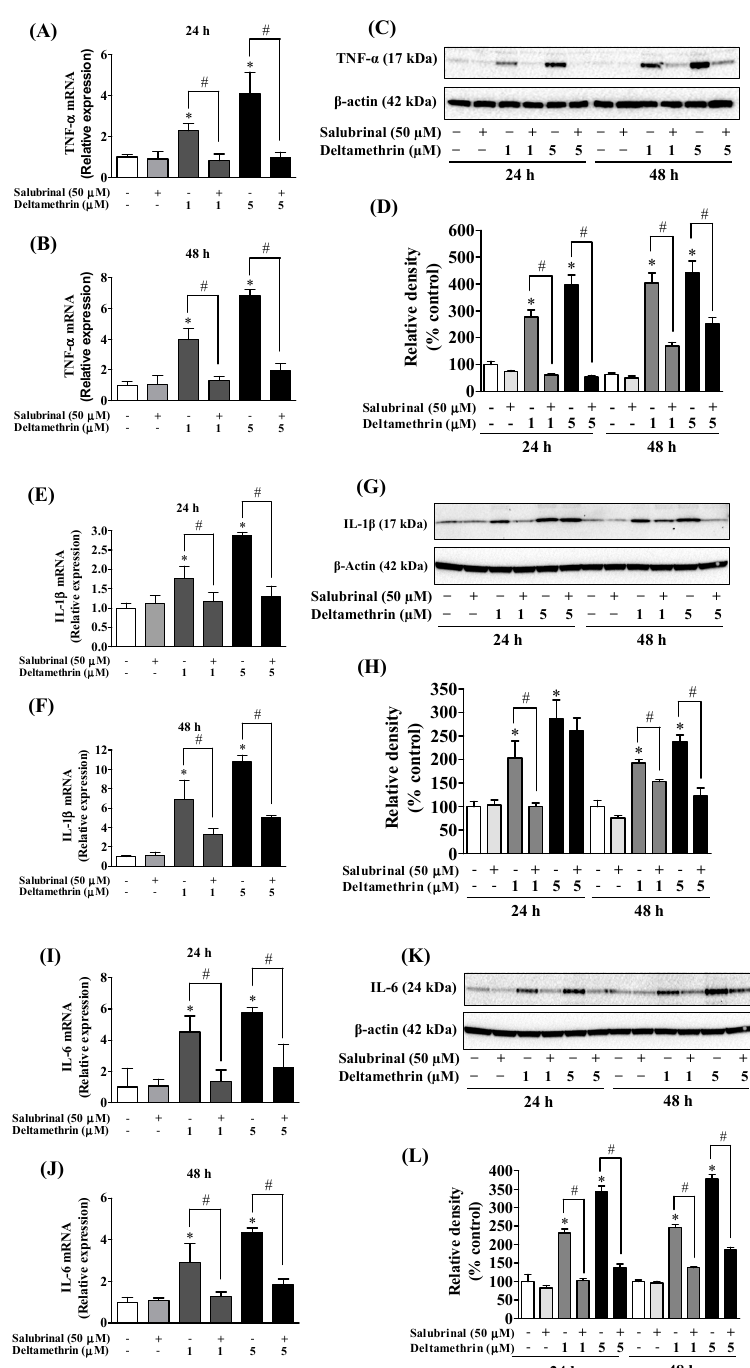
Figure 8. Salubrinal reduces deltamethrin-induced increased levels of inflammatory cytokines in MMCs. ( A , B ) mRNA and ( C , D ) protein levels of TNF- α ; ( E , F ) mRNA and ( G , H ) protein levels of IL-1 β ; ( I , J ) mRNA and ( K , L ) protein levels of IL-6. The protein bands were quantified by densitometry and the results reported as relative band densities. As the membrane was stripped and re-probed with anti-IL-6 after IL-1 β , the same loading control was used for both proteins. The values represent mean ± SEM from three independent experiments, each of which was performed in triplicate. An asterisk denotes significant difference from the control group, and a hashtag denotes significant differences between deltamethrin and deltamethrin + salubrinal ( p <